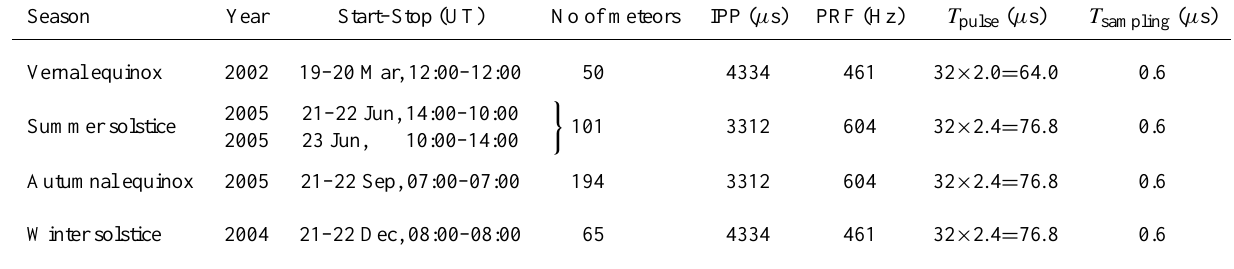
Table 1. Season, year, start/stop dates and times, number of detected tristatic meteors, interpulse period (IPP), pulse repetition frequency (PRF) with two pulses per IPP, pulse length ( T pulse ), and receiver sampling period ( T sampling ) for the meteor campaigns with EISCAT